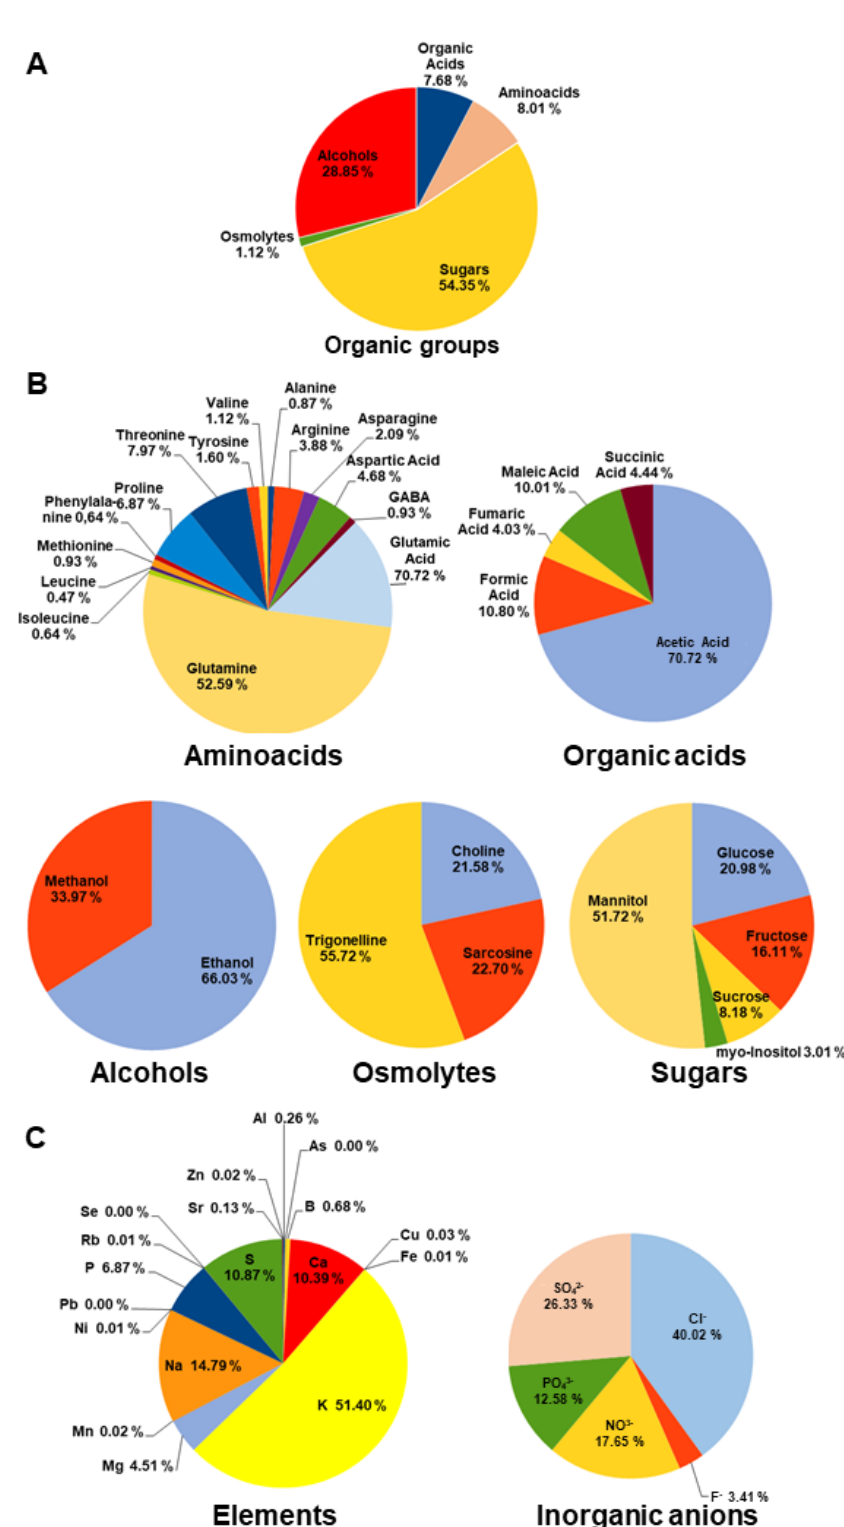
Figure 1. Percentage composition of the different organic groups ( A ), amino acids, organic acids, alcohols, sugars, osmolytes ( B ) mineral elements and inorganic ions ( C ) detected in all olive xylem sap samples analyzed in the study.